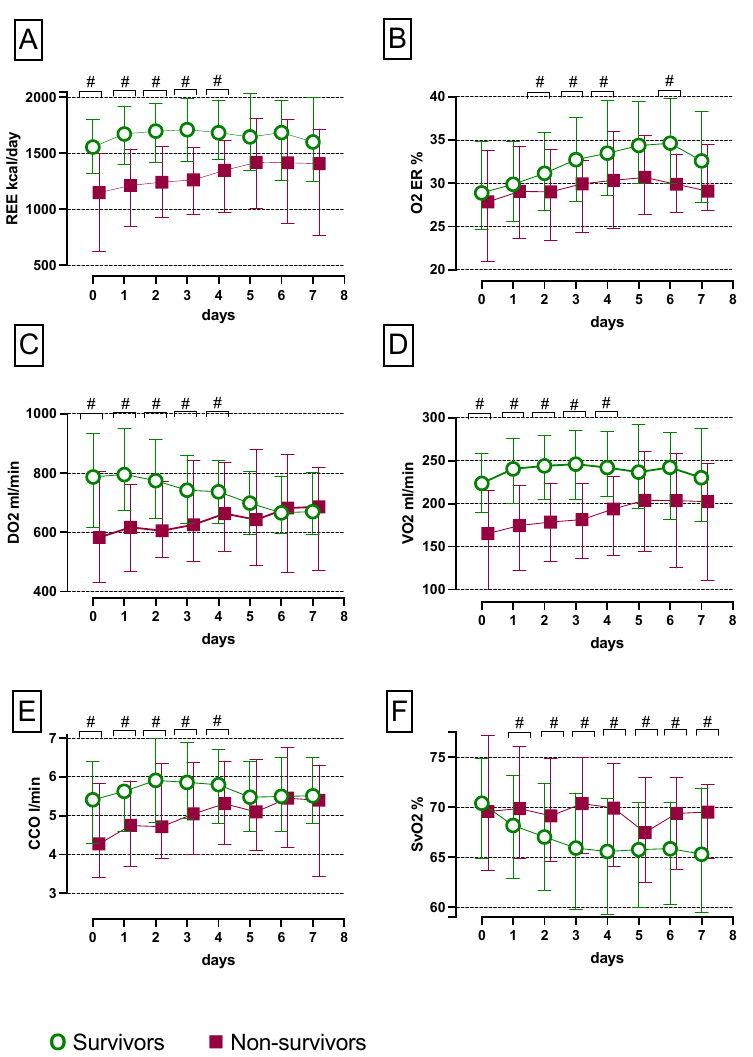
Figure 2. CCO, SvO 2 , DO 2 , VO 2 , O 2 ER and REE of survivors and non-survivors during the first seven days. In non-survivors, the REE median was significantly reduced compared with survivors over the first 4 days, but not on days 5, 6 and 7 ( A ). Non-survivors had significantly lower O 2 ER values on post-operative days 2, 3, 4 and 6 compared with survivors after heart surgery ( B ). DO 2 was significantly lower in non-survivors during the first 4 days, but not on days 5, 6 and 7 ( C ). In non-survivors, VO 2 was significantly decreased within the first 4 days ( D ). CCO was significantly lower in non-survivors over the first 5 days ( E ). SvO 2 significantly rose from day 1 until day 7 in non-survivors compared with survivors ( F ). Patients included per day: n = 566; day 0: n = 463; day 1: n = 515; day 2: n = 405; day 3: n = 292; day 4: n = 203; day 5: 115; day 6: 73; day 7: n = 42. CCO, continuous cardiac output; DO 2 , oxygen delivery; O 2 ER, oxygen extraction ratio; REE, resting energy expenditure; SvO 2 , mixed venous oxygen saturation; VO 2 , oxygen consumption; # p < 0.05. Non-survivors had solely significantly lower O 2 ER values on post-operative days 2, 3, 4 and 6 compared with survivors after heart surgery, as demonstrated in Figure